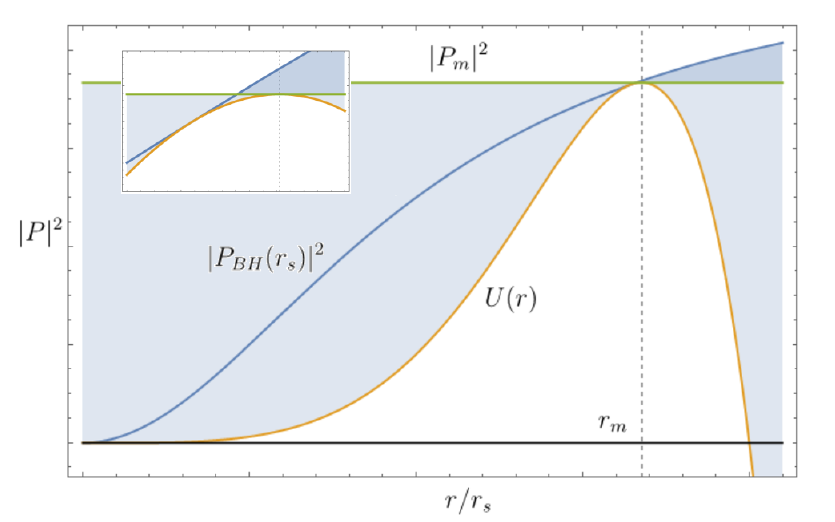
Figure 6 . Generic form of the potential U ( r ) = f ( r ) r 2( d (cid:0) 1) (yellow curve) as a function of r BH (cid:0) for black holes with k = 1 and d 3, or for BTZ black holes in d = 2. The peak of the potential (cid:21) corresponds to r m (dashed gray line) and the corresponding energy P 2 (green line) is de(cid:12)ned in m eq. (3.68). The blue curve corresponds to the energy in the black hole side as a function of r s where the shell is crossed, for k = 1 and d 3 or for BTZ black holes in d = 2 with the Neveu-Schwarz (cid:21) vacuum. The point where the yellow and blue curves meet indicates a change in the direction of the velocity _ r BH ( r s ). To reach the asymptotic boundary we require P 2 P 2 . That is, r s should BH (cid:21) m be larger than the value at the intersection of the blue and green curves | see